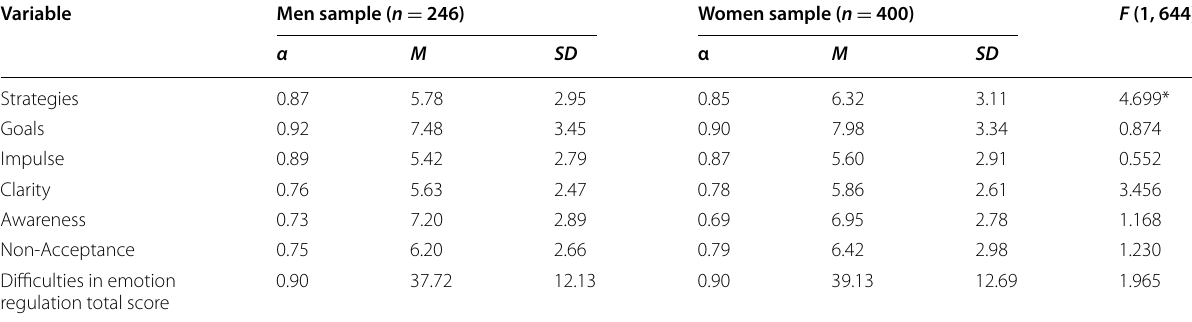
α Cronbach’s alpha, M mean, SD standard deviation, DERS-SF Difficulties in Emotion Regulation Scale – Short Form * p < 0.05 a One-way